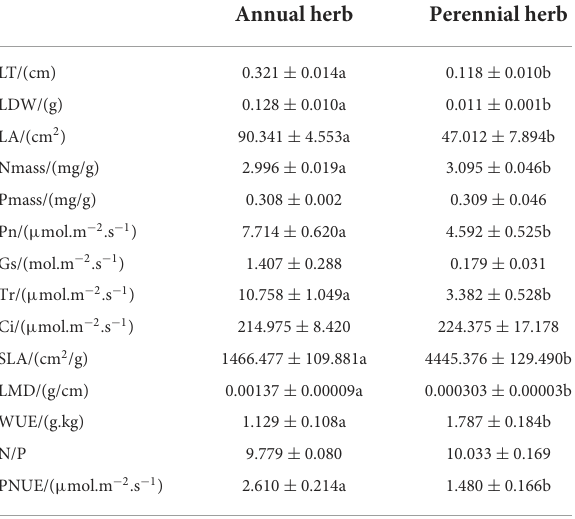
TABLE 5 Leaf functional traits of plants of different life forms in the fluctuating zone of Three Gorges Reservoir (mean ± standard error). Annual herb Perennial herb